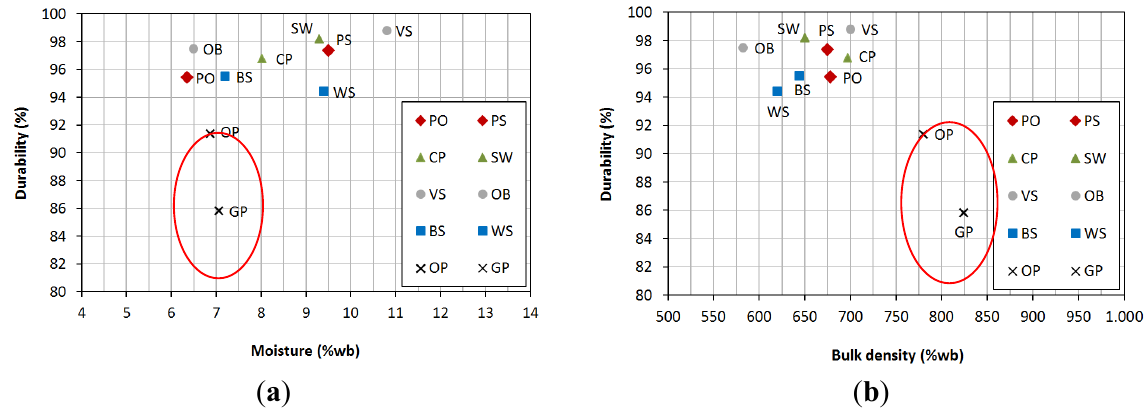
Figure 1. Relationships between ( a ) moisture and durability; ( b ) bulk density and